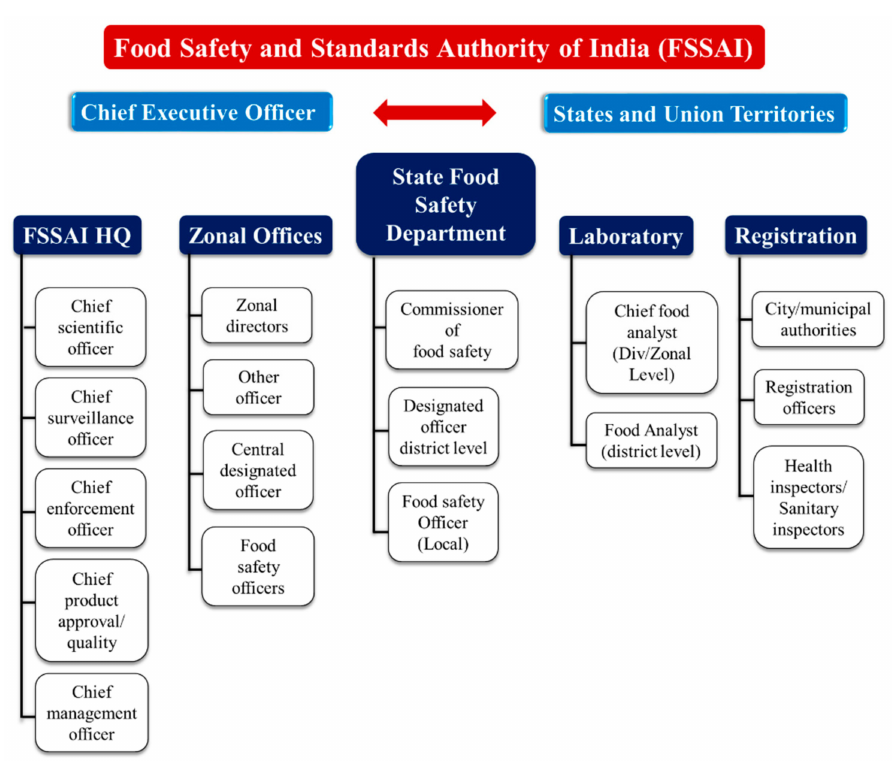
Figure 13. Food safety monitoring organizational structure of